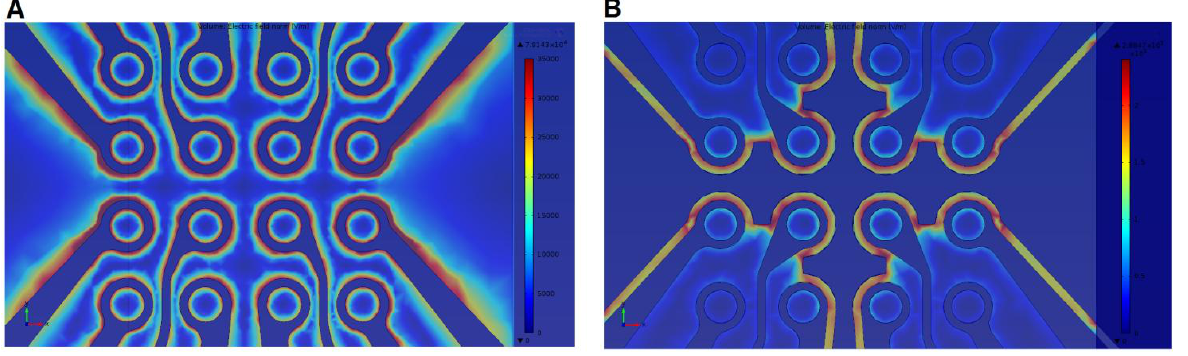
Figure 5. Simulation of electric field distribution over the dot electrode: ( A ) without ground plane between dot apertures; ( B ) with ground plane between dot apertures. Reproduced with permission from